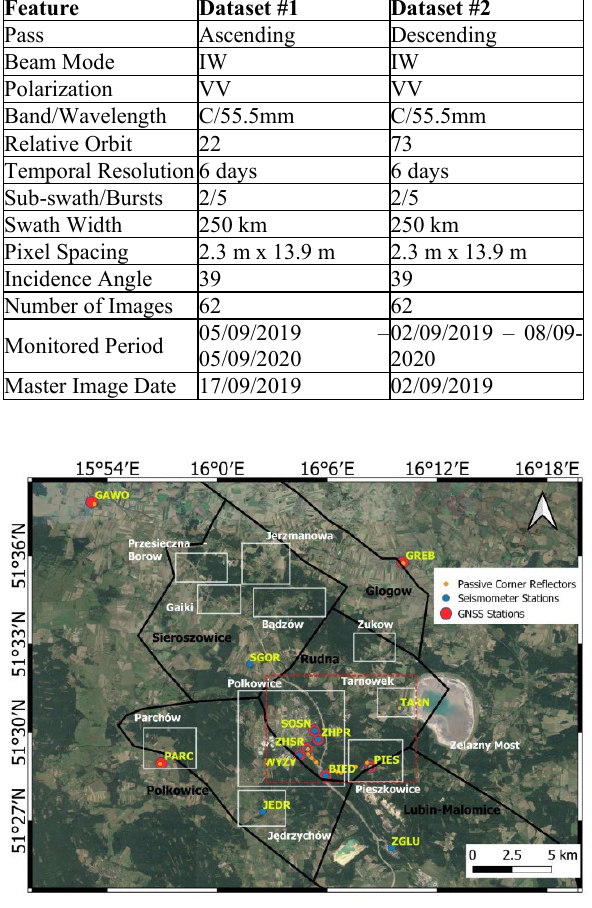
Figure 1 . Overview of the area of interest in the Lower Silesian region, Poland. The locations of passive corner reflectors are indicated, and the locations and names of the seismometers and GNSS stations. Areas affected by strong deformations are indicated in white, mining areas are indicated in black